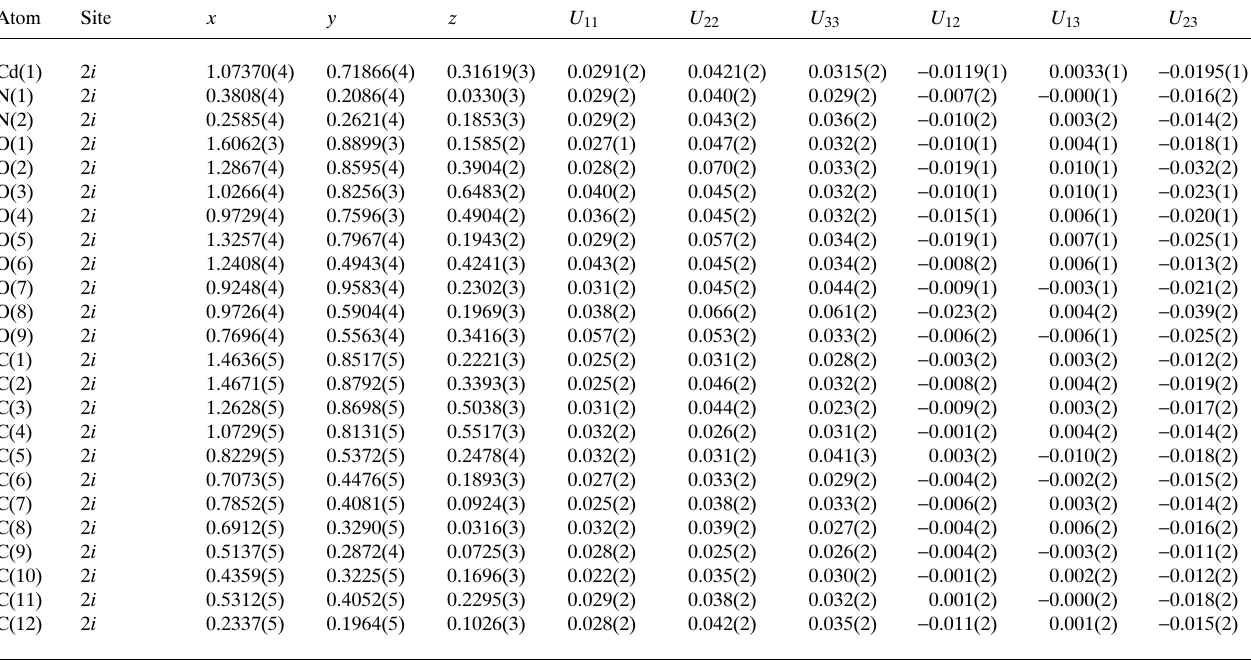
Table 3. Atomic coordinates and displacement parameters (in Å 2 ) .